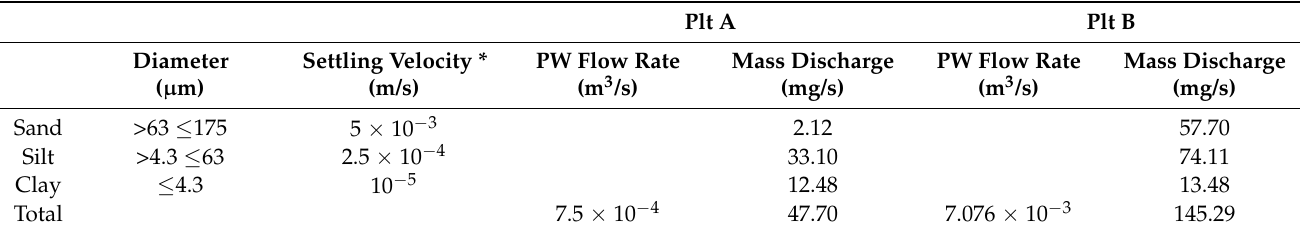
Table 2. Particle class sources settings (continuous discharge 7 h per day).